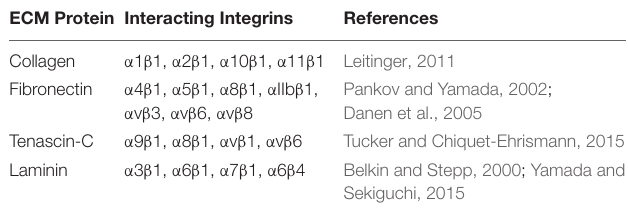
TABLE 3 | Integrins and their ECM partners. ECM Protein Interacting Integrins